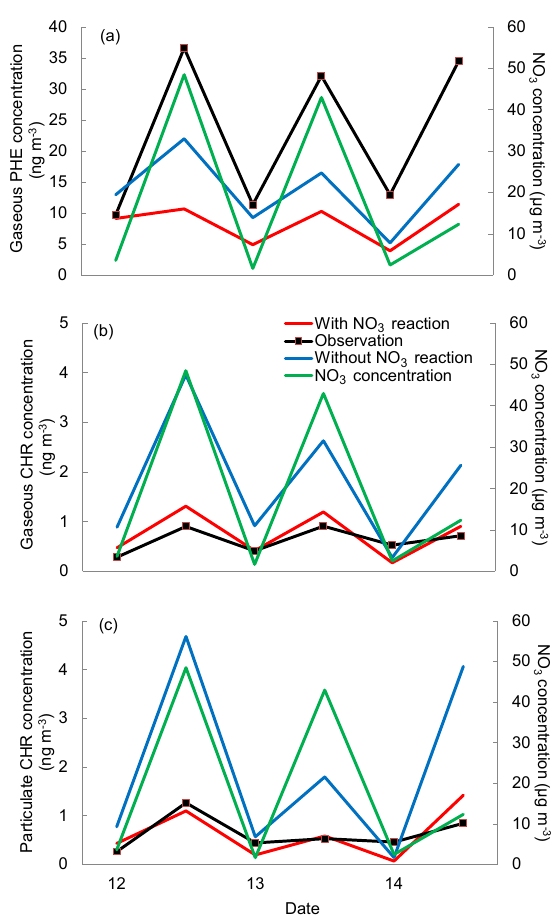
Figure 9. Simulated concentrations of (a) gaseous PHE, (b) gaseous CHR and (c) particulate CHR with and without reactions of NO 3 compared with observation and simulated concentrations of NO 3 during 12–14 July